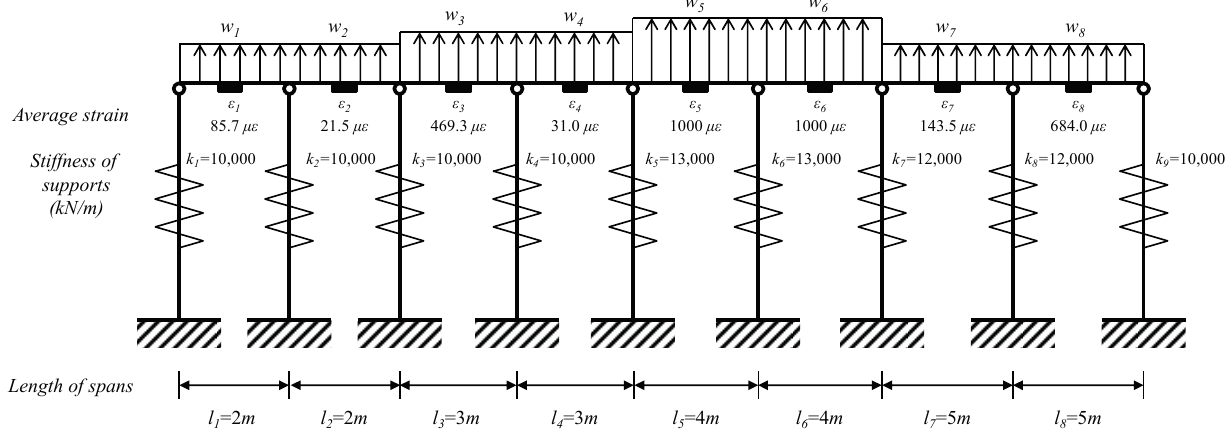
Figure 8. Schematic diagram for the 8-span beam with irregularities in geometry, mechanical properties, and magnitudes of lateral